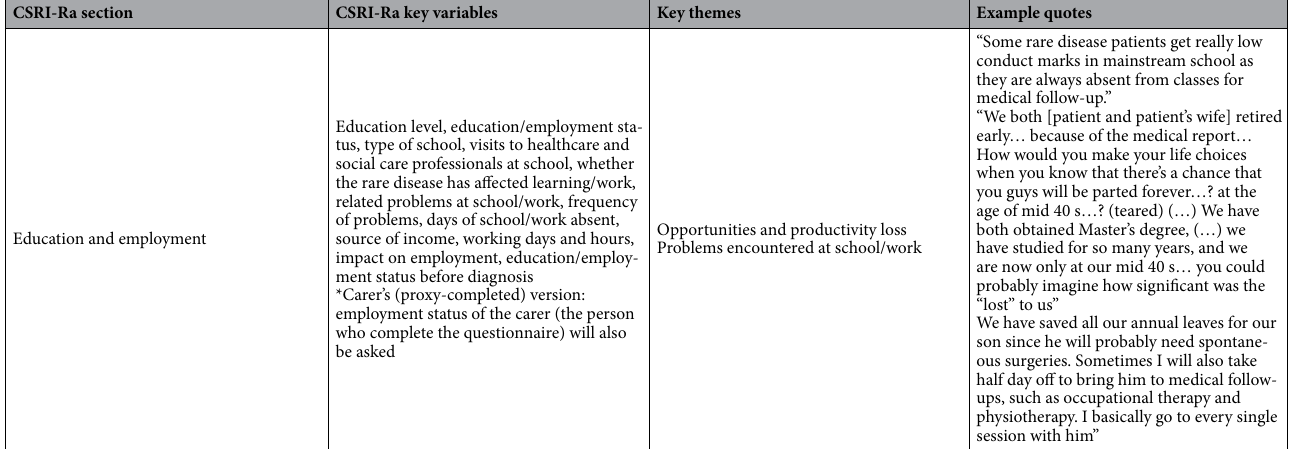
Table 3. Key sections and variables of the CSRI-Ra supported by key themes and example quotes. This table is based on the patient’s version of the CSRI-Ra. The patient’s and carer’s versions are almost identical, with minor differences in section orders. A&E accident and emergency, CSRI‑Ra Client Service Receipt Inventory for RAre genetic disease